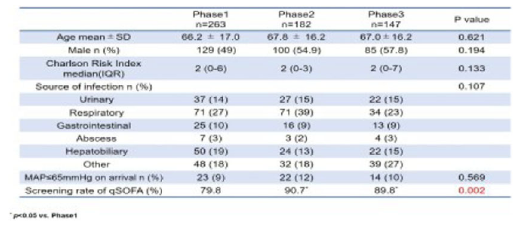
Table 1 (abstract 000343). Baseline characteristics